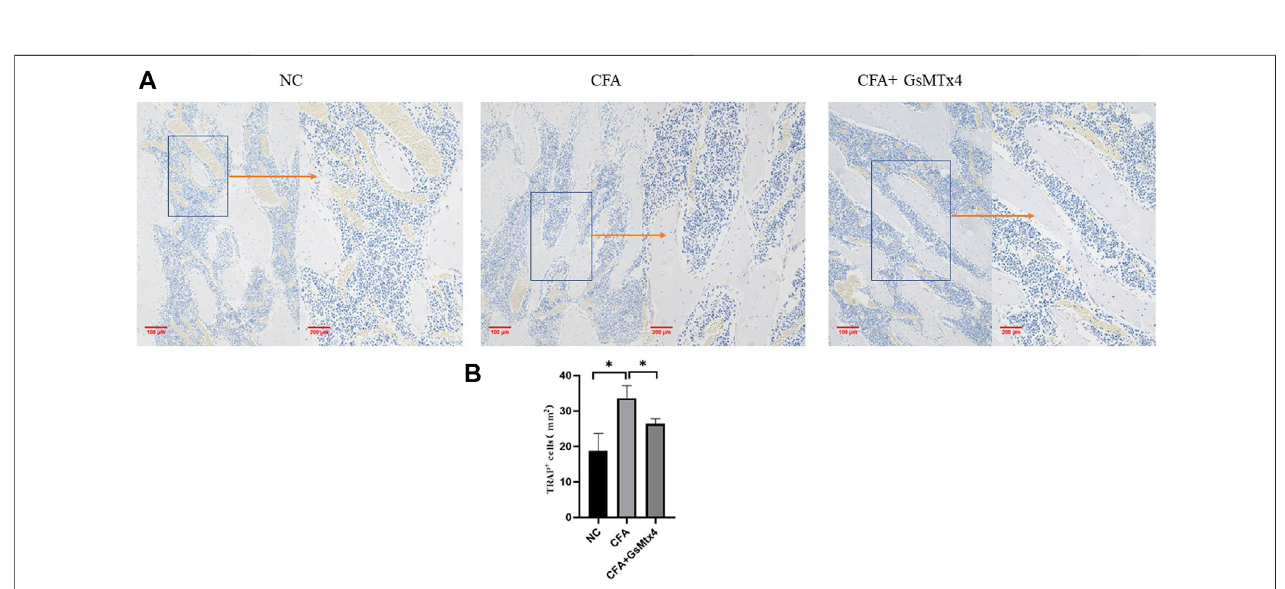
FIGURE 4 | (A) Distribution of osteoclasts in each group; (B) Statistical analysis of the number of osteoclasts in each group. * p < 0.05.